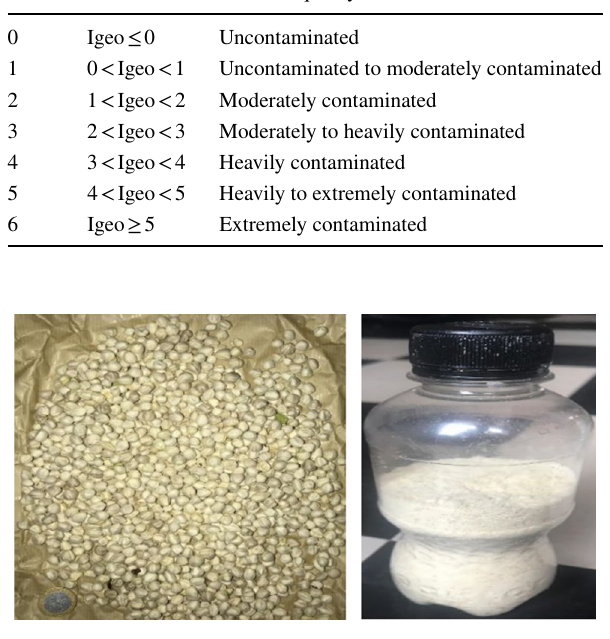
Fig. 2 Moringa oleifera seeds (Personnal data)